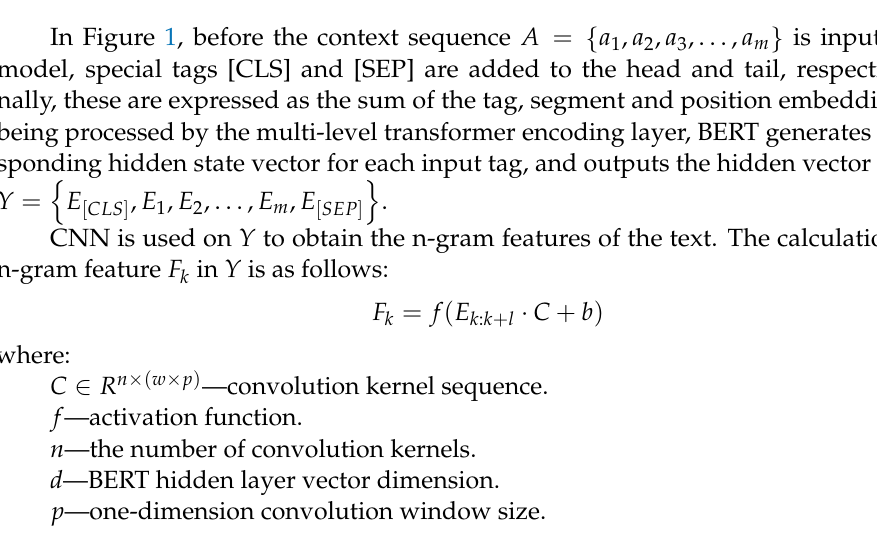
Figure 1. Structure of BERT-CAM network model.